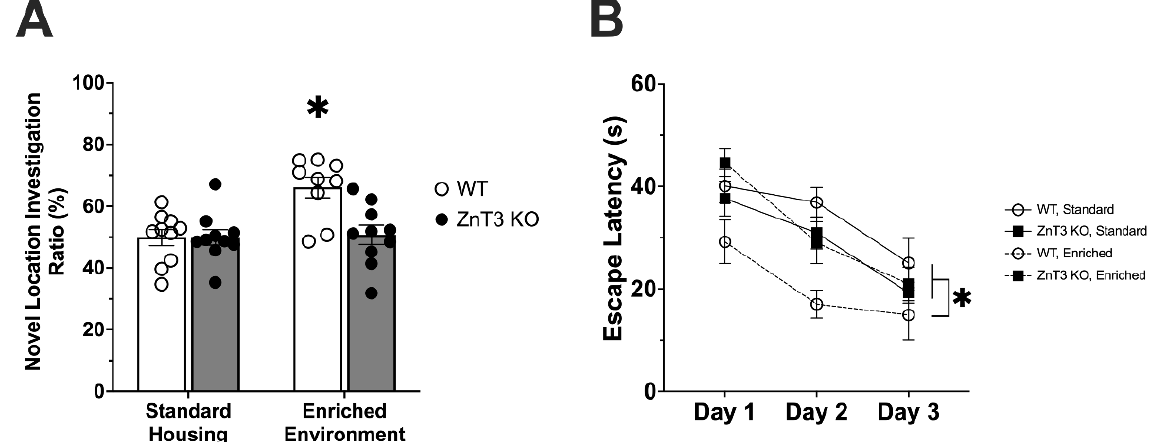
Figure 4. Spatial learning and memory in WT and ZnT3 KO mice exposed to SH or EE ( n = 39). ( A ) EE exposure increases the investigation ratio of a novel object for WT mice, but not for ZnT3 KO mice, in the spatial object recognition task. ( B ) Escape latencies in the Morris Water task across the three testing days reveal that the performance of WT mice in the EE housing condition is significantly better than ZnT3 KO-EE, as well as that of WT or ZnT3 KO mice in SH. Error bars represent ± standard error of the mean. * p <